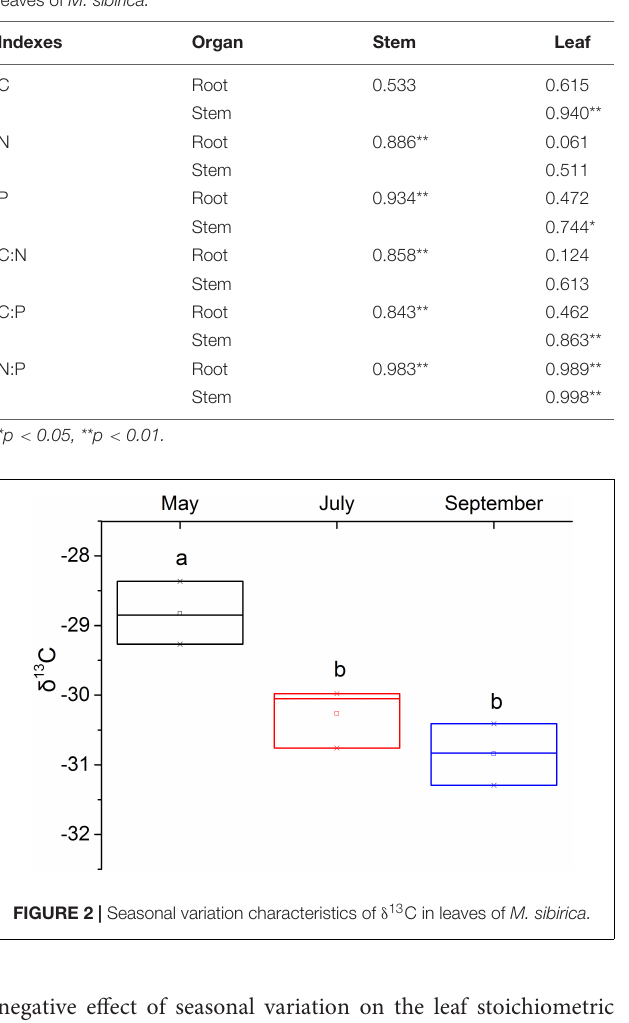
negative effect of seasonal variation on the leaf stoichiometric P was greater than the positive effect of WUE on it, and the positive effect of WUE on the leaf N content was greater than the positive effect of seasonal variation on it. In addition, leaf C content was more significantly influenced by the direct effect of WUE. Leaf P content was influenced by the opposite effects of seasonal variation and WUE, while leaf N content was influenced by the same positive effect of both.